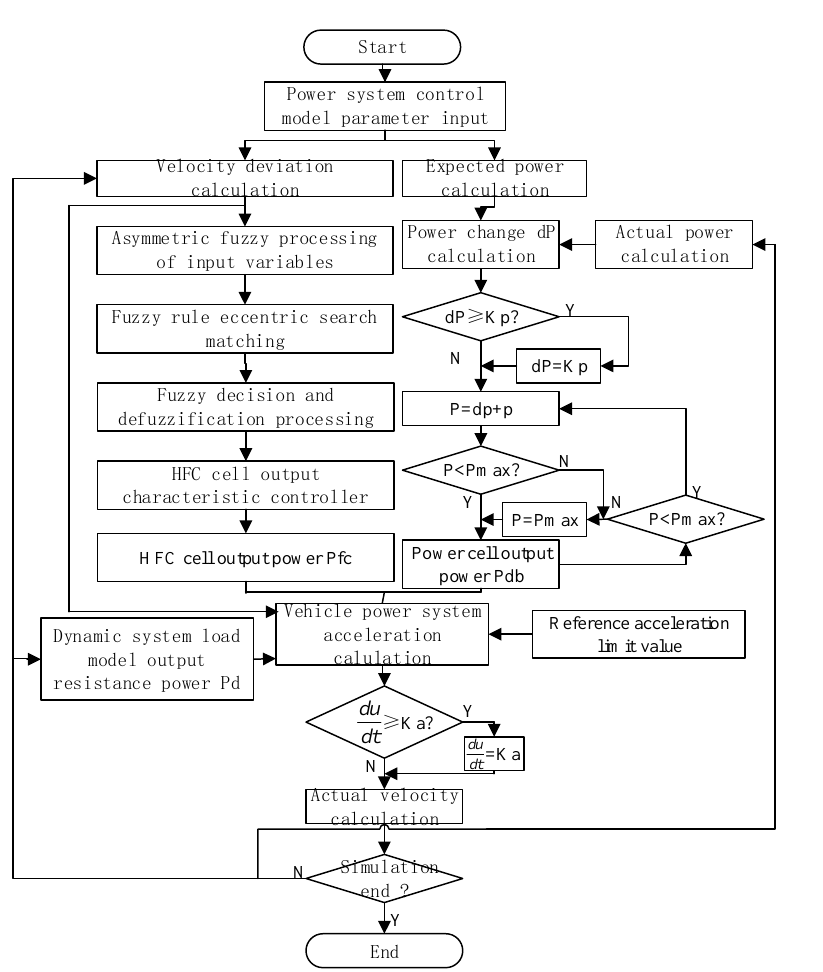
Figure 6. Improved fuzzy adaptive PID control algorithm control flow.